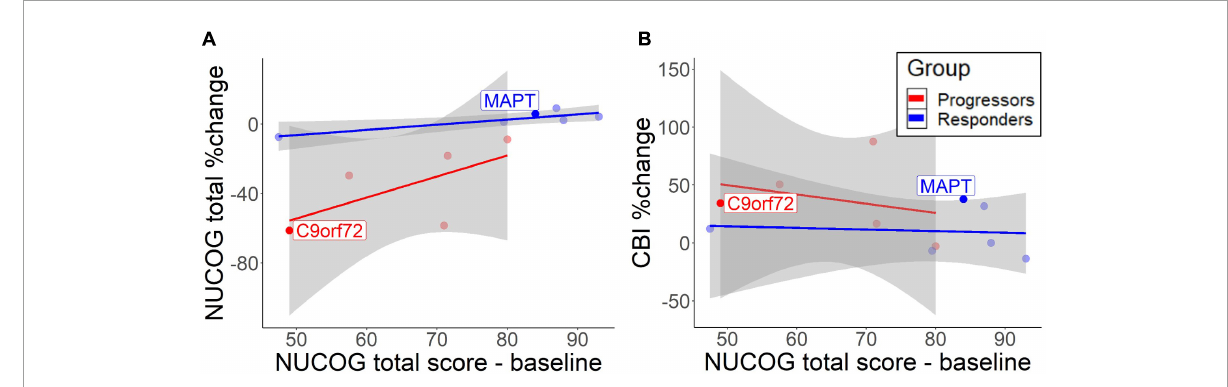
FIGURE2 Correlation between baseline total NUCOG scores and cognitive decrease (A) and behavioral change (B) . The lines represent different groups. Results are based on bootstrapped Pearson correlations. Both patients with the identified mutation are highlighted.